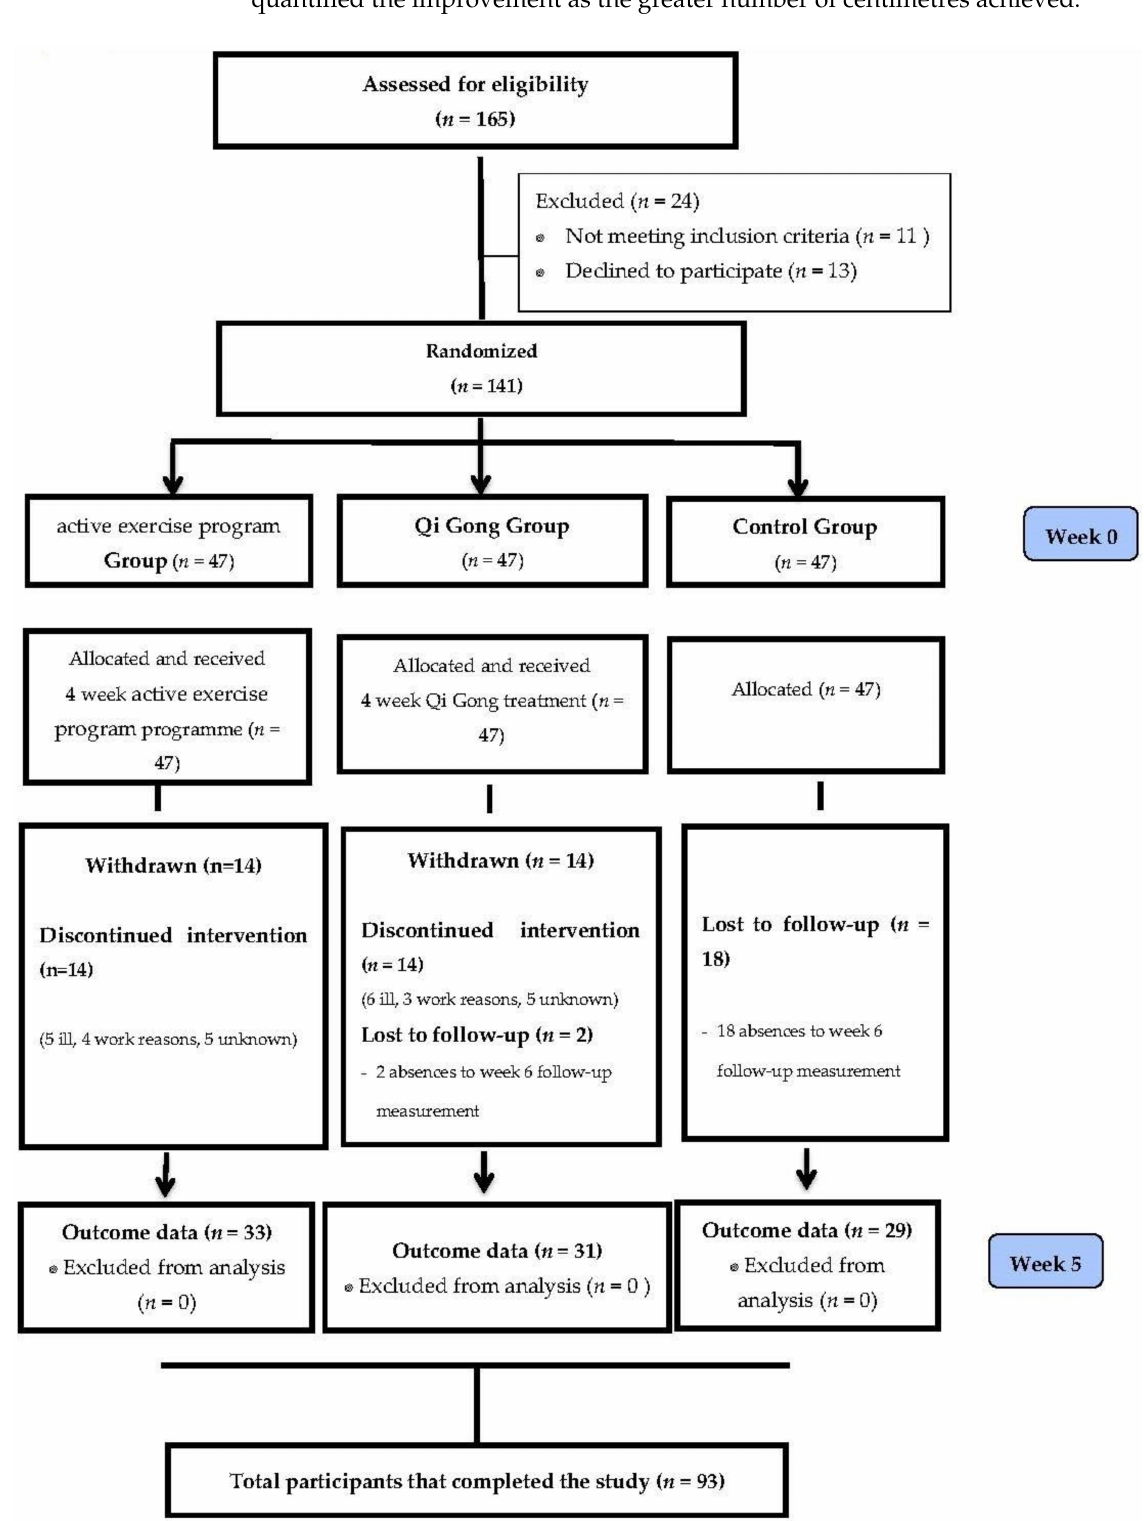
Figure 1. Flow diagram of study